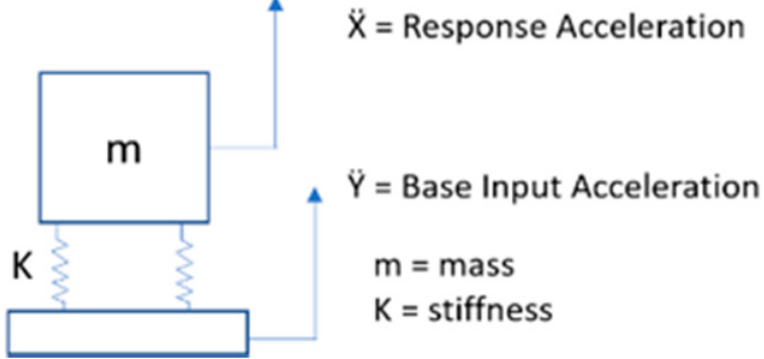
Table 1. Rainflow cycling counting. Figure 2. Response to a base acceleration. Figure 2. Response to a base acceleration.